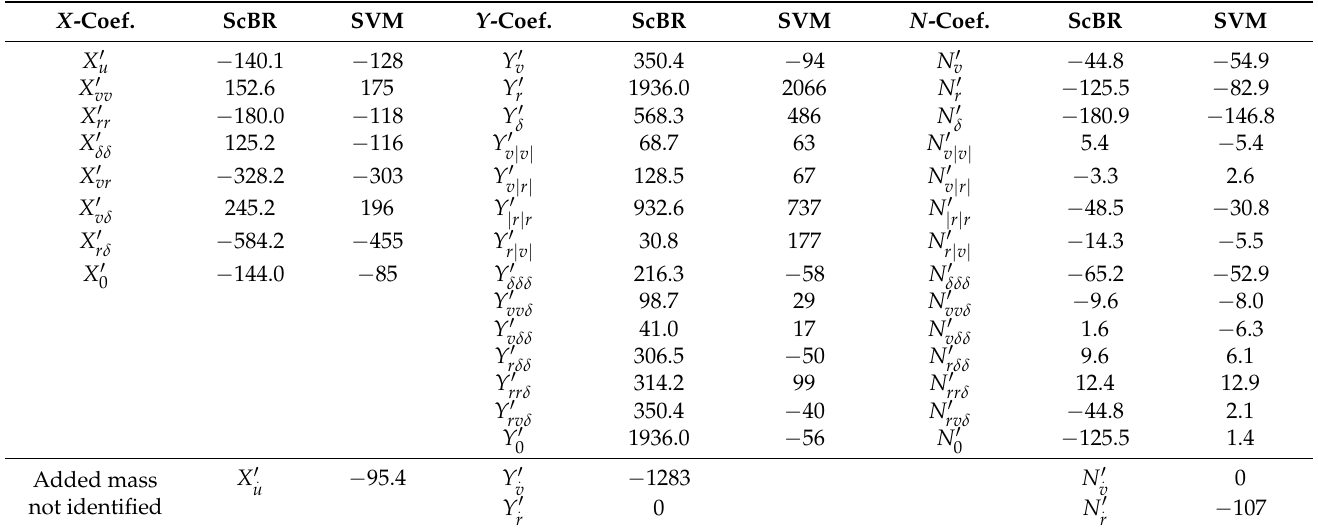
Table 3. The nondimensional hydrodynamic parameters for ScBR and SVM (1 × 10 − 5 ). X